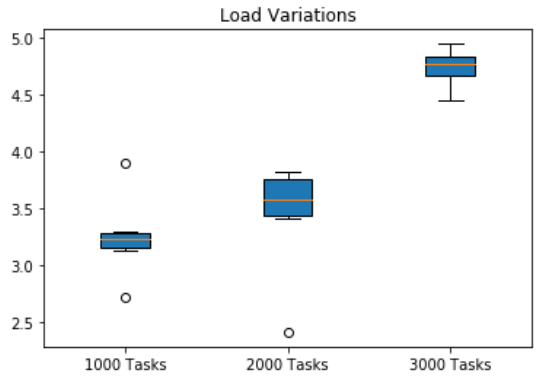
Figure 14. Workload Variations.